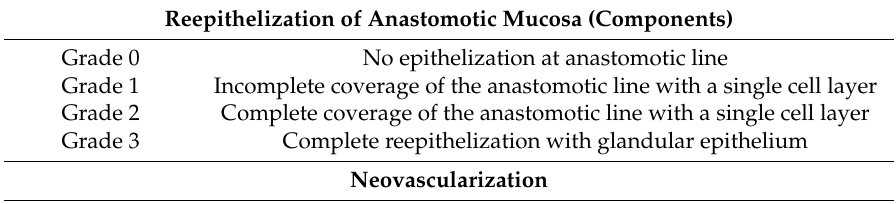
Table 1. Descriptive table of the histopathological grading scores [8].